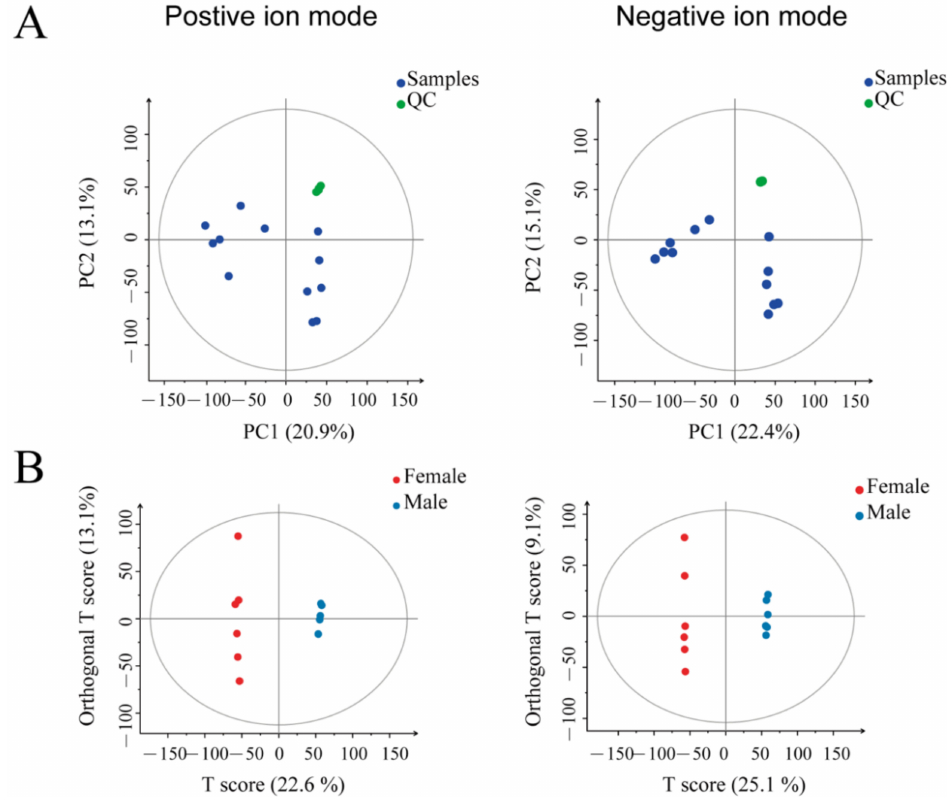
Figure 2. Clusters of the samples based on the relative contents of all metabolites: ( A ) PCA of samples under the positive and negative ion mode, respectively. The green dots represent the quality control (QC) samples, and the blue ones represent the experimental samples; ( B ) OPLS-DA is based on the normalized metabolomics data under the positive and negative ion modes.